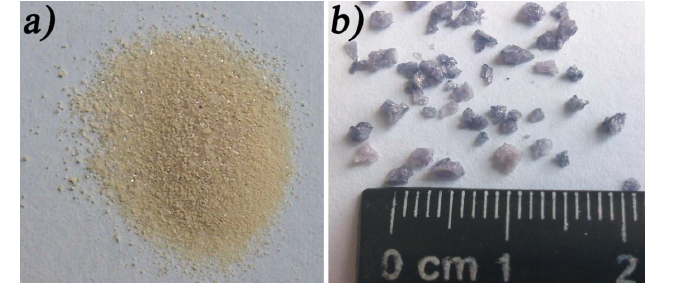
Figure 4 FTIR spectra of (I) (curve 1) and (II) (curve